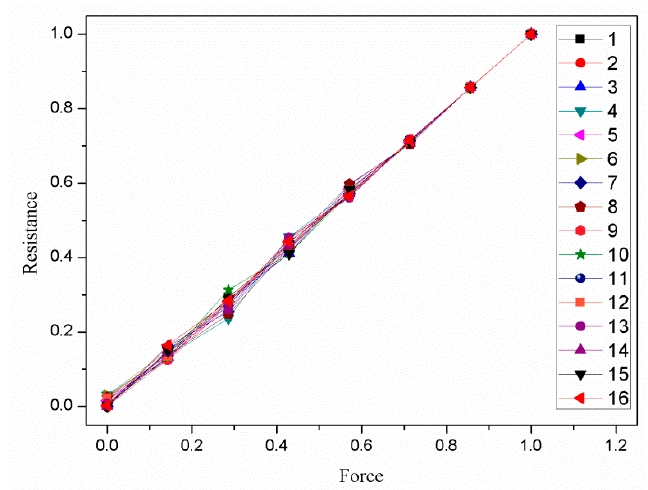
Figure 14. The normalized sample data.